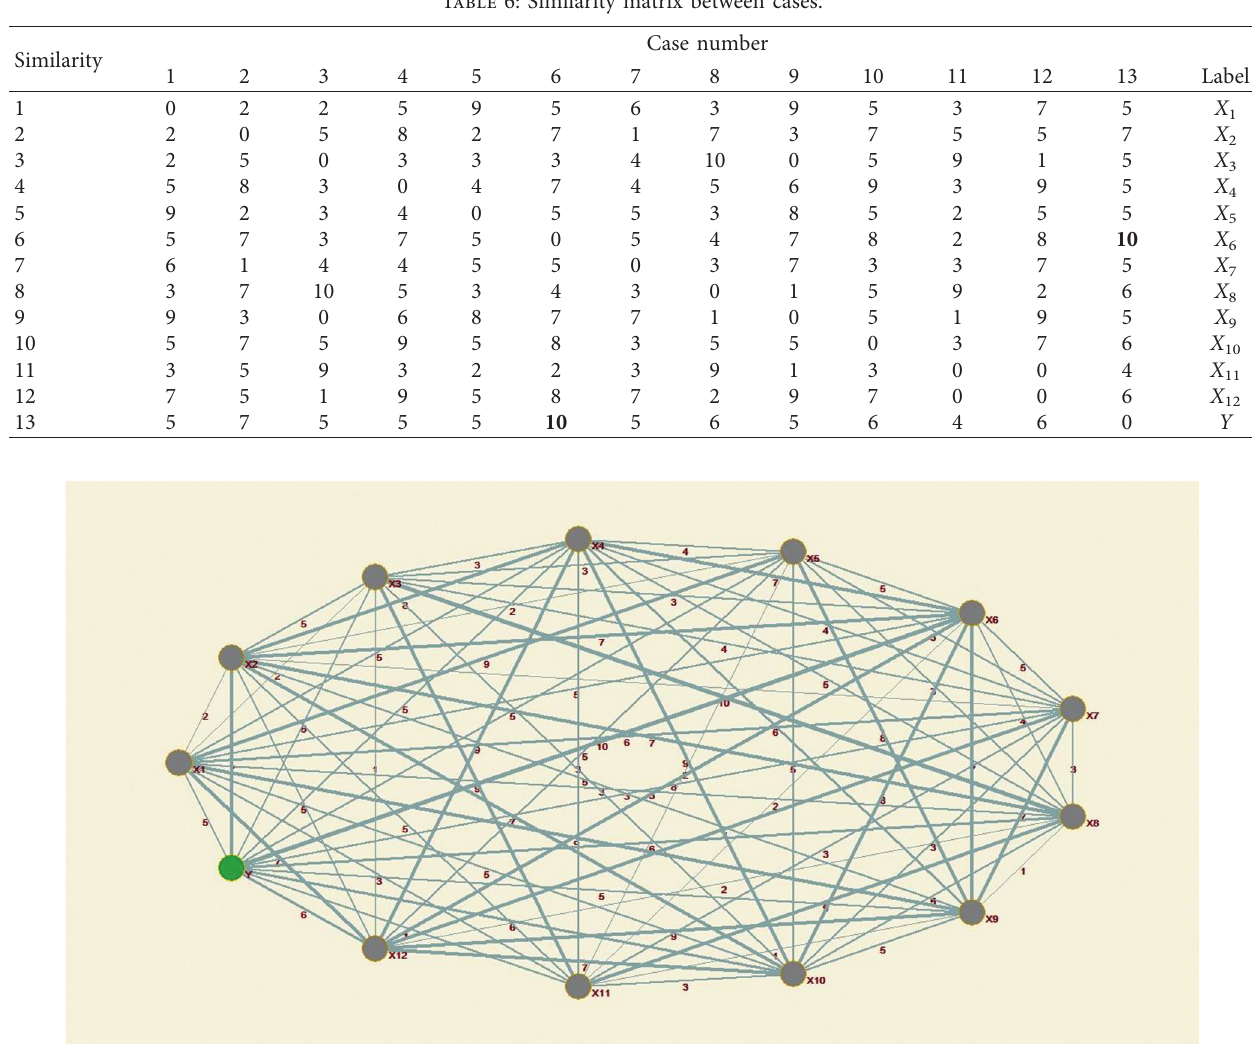
Figure 2: Case similarity analysis based on complex network, represented by the all closeness